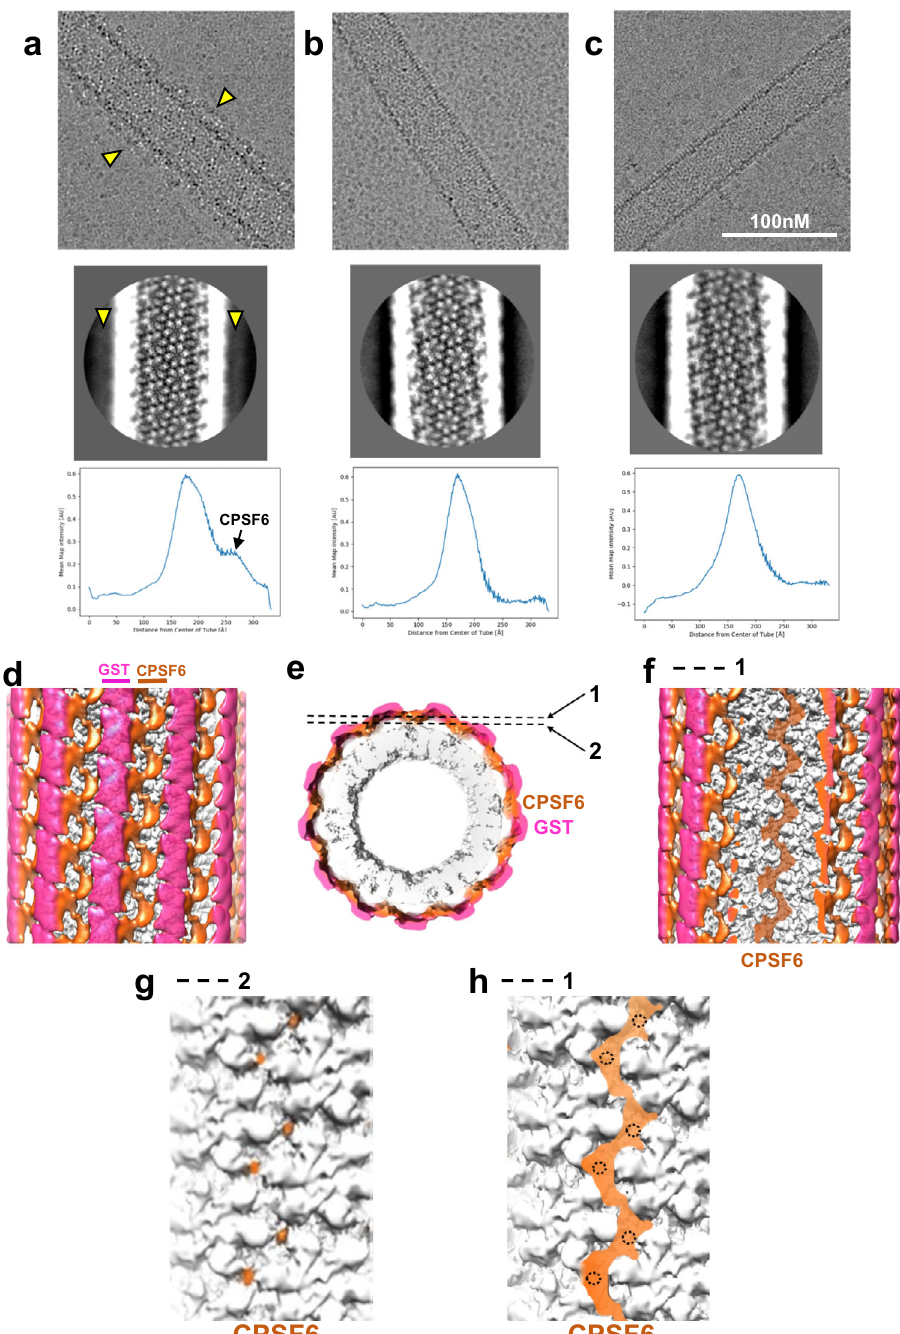
Fig. 5 | Cryo-EM analysis of CPSF6(LCR-FG-LCR) binding to IP6-stabilized CA tubes. Images of CA(A92E) tubes in the presence of WT GST-CPSF6 261-358 ( a ); GST- CPSF6 261-358 ( Δ FG), which contains LCR sequences but lacks the CA binding FG residues ( b ); and GST-CPSF6/AD(FG-nonLCR), which contains the CA binding 15- merFGpeptidebutwhere fl ankingLCRsarereplacedwithnonLCRsequencesfrom ADD2 ( c ). Partially ordered additional density (indicated by yellow arrow heads) along the surface of CA nanotubes was consistently observed in CA+WT GST- CPSF6 261-358 (LCR-FG-LCR)samples( a ,top).Thisadditionaldensitywasalsoevident in 2D class averages ( a , middle, yellow arrow heads) and in 1D density pro fi les ( a , bottom). In contrast, no additional density was apparent after addition of GST- CPSF6 261-358 ( Δ FG) ( b ) or GST-CPSF6/AD(FG-nonLCR) ( c ) to CA nanotubes. The